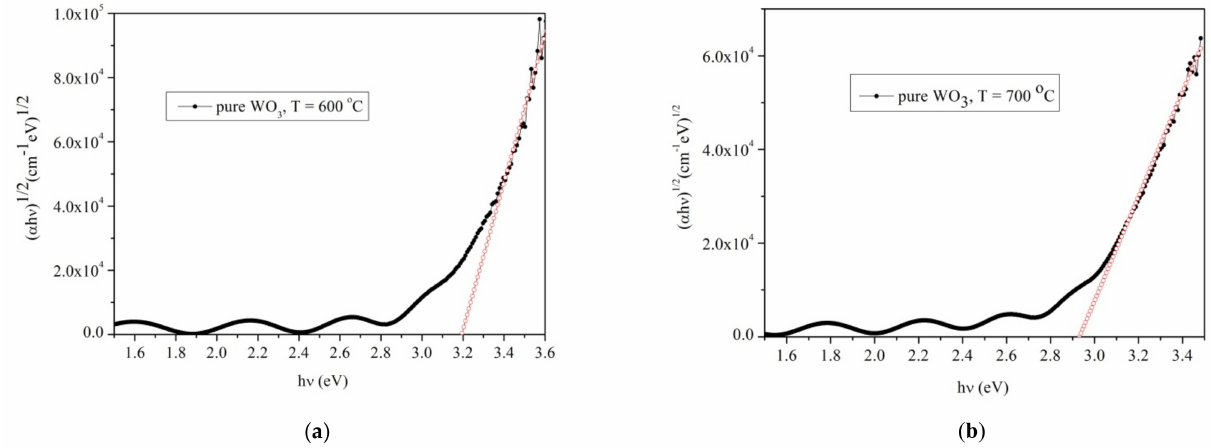
Figure 11. Optical band gap of pure WO 3 layers grown on sapphire substrates: ( a ) sample at 600 ◦ C ( b ) sample at 700 ◦ C.